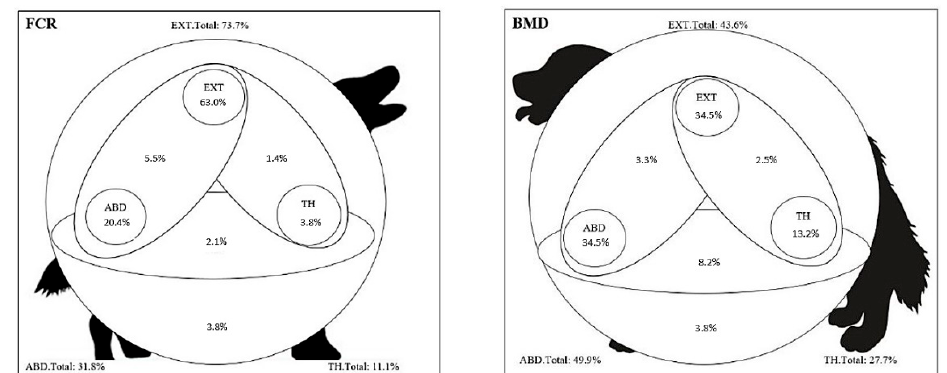
Figure 1. Involvement of the body compartments in HS in the FCR ( left ) and BMD ( right ). The distribution is significantly different between these two breeds ( p < 0.001). EXT: any organ external to abdomen/thorax; ABD: abdominal; TH: thoracic. Table 4. Comparison of tumor location of HS in FCR and BMD.